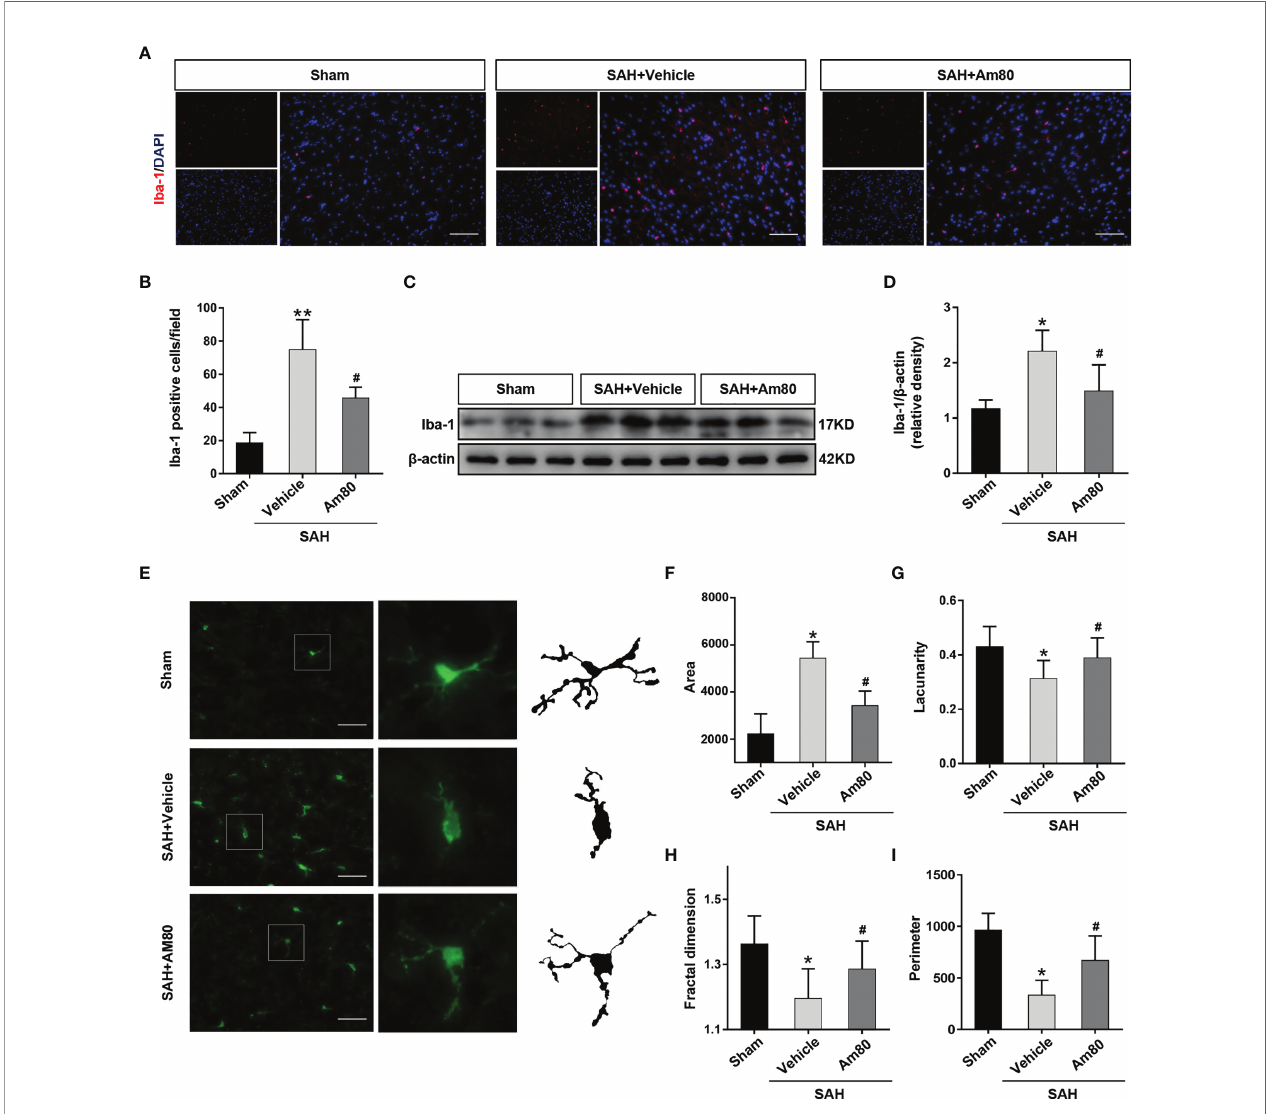
FIGURE 5 | Am80 attenuated the excessive activation of microglia after SAH. (A, B) Immuno fl uorescence staining and quantitative analysis of activated microglia (Iba-1). Scale bar = 100 m m. n = 3 per group. (C, D) Western blotting and quantitative analyses of Iba-1 expression. n=6 per group. (E – I) Representative images of activated-microglia (green) used for the measurement of morphological parameters and quanti fi cation analysis, including area, lacunarity, fractal dimension and perimeter in the basal cortex. Scale bar = 50 m m. n=6 per group. * P < 0.05 vs sham group; ** P < 0.01 vs sham group; # P < 0.05 vs SAH+vehicle